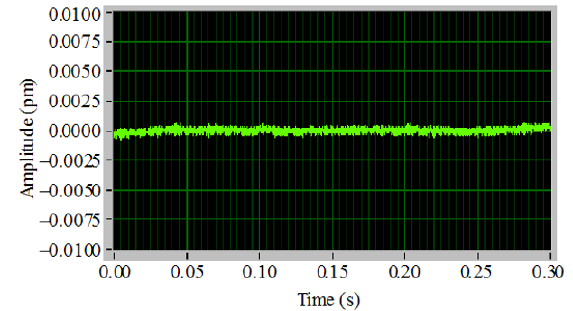
Fig. 6 Background noise of the fiber laser hydrophone